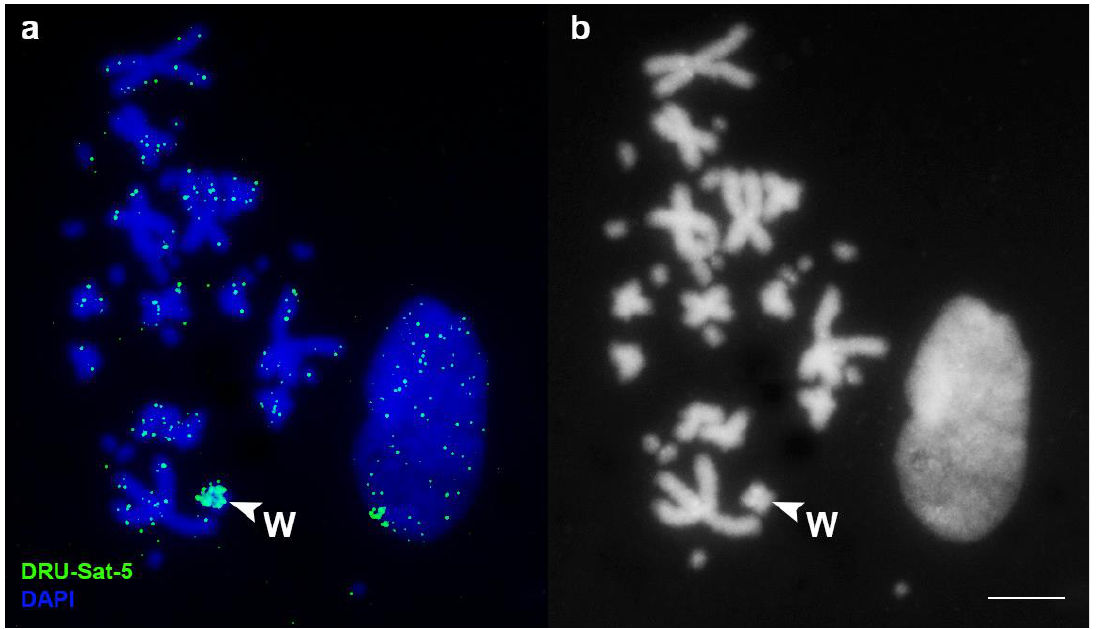
Figure 5. Localization of the satellite DRU-Sat-5 in the chromosomes of D. russelii . W: the W chromosome. (a) Merged image; (b) DAPI channel. Scale bar: 10 μ m.